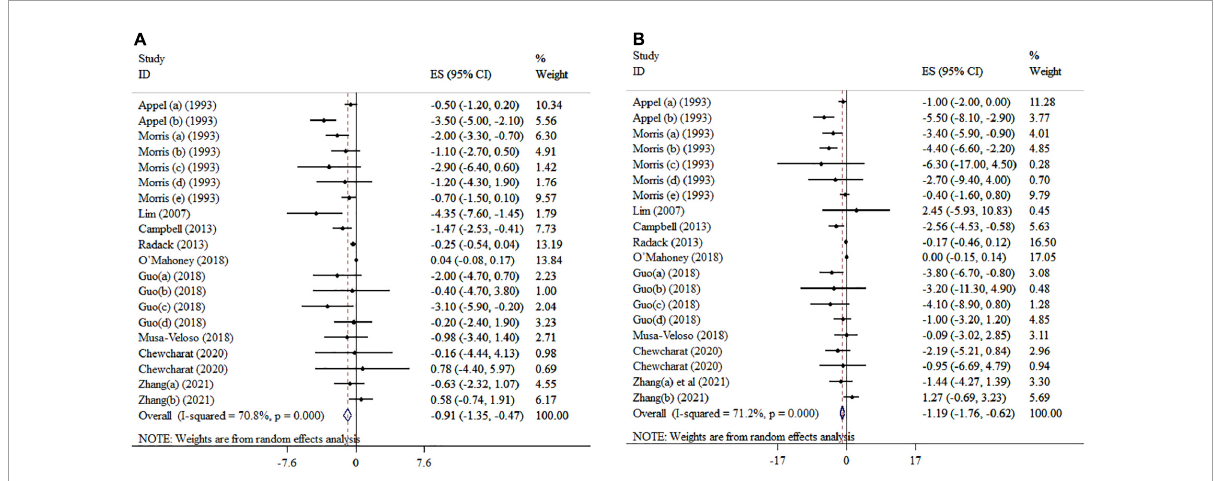
FIGURE2 Mean difference and 95% CIs presented in forest plots of the studies on the effects of n-3 PUFA supplementation on DBP (A) , and SBP (B) levels (a, b, c, d, etc. indicates a separate effect size for different diseases in each